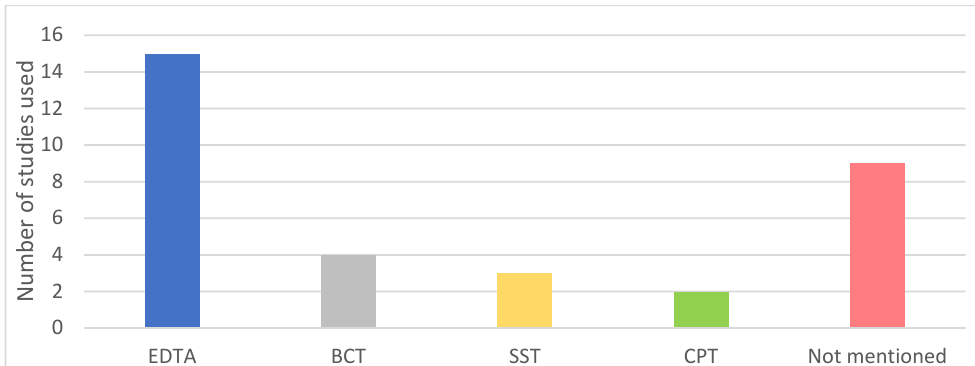
Figure 2. Types of collection tubes used in included studies. EDTA: Ethylenediamine tetraacetic acid; SST: serum-separating tube; CPT: cell preparation tube; BCT: blood collection tube with a preservative stabilizing nucleated blood cells (Streck).